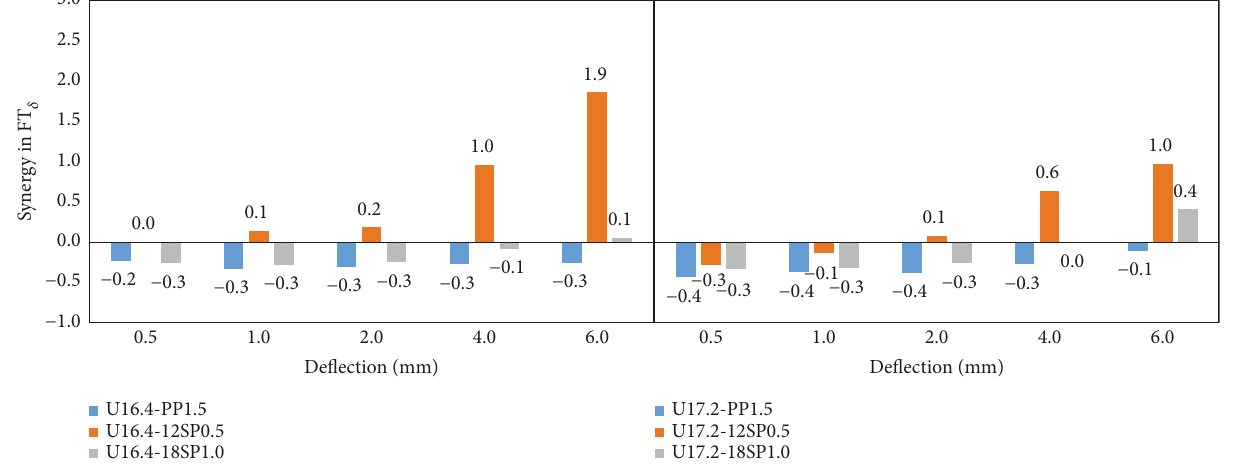
Figure 10: Synergy in fl exural properties based on a four-point fl exural load-de fl ection curve.